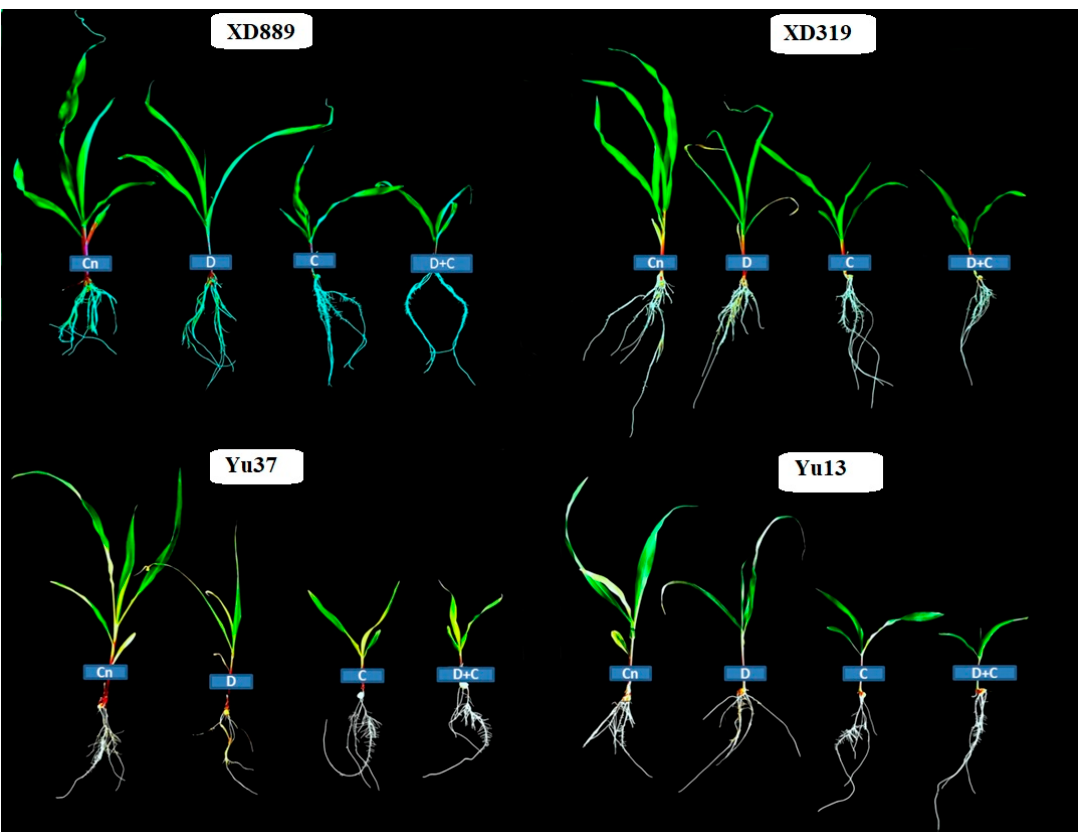
Figure 2. Individual and interactive effect of drought and chilling stresses on the seedlings growth of maize (cv. XD889, XD319, Yu13, Yu37). Cn—control, D—drought, C—chilling, D + C—drought + chilling.